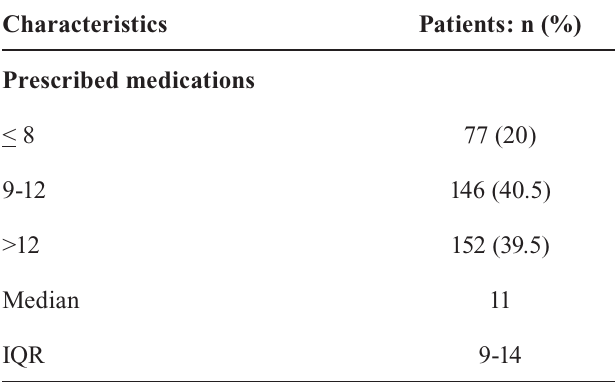
Characteristics